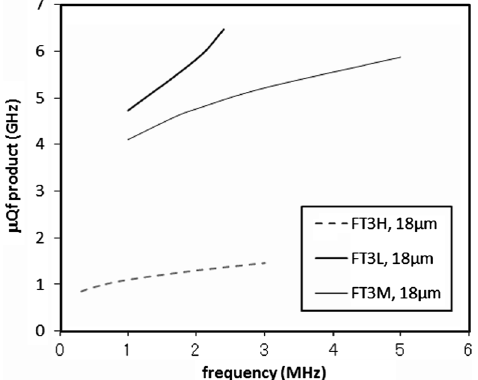
FIG. 14. Characteristics of the magnetic alloy core, FT3M, FT3L, and FT3H with same ribbon thickness of 18 (cid:1) m . The FT3M cores (thin lines) are currently used for the J-PARC. The FT3L (bold lines) shows about 20% higher (cid:1) 0 p Qf product than the FT3M. The FT3H is the material annealed with the magnetic field with a different direction than that of the FT3L. This material shows a lower impedance than the other materials.